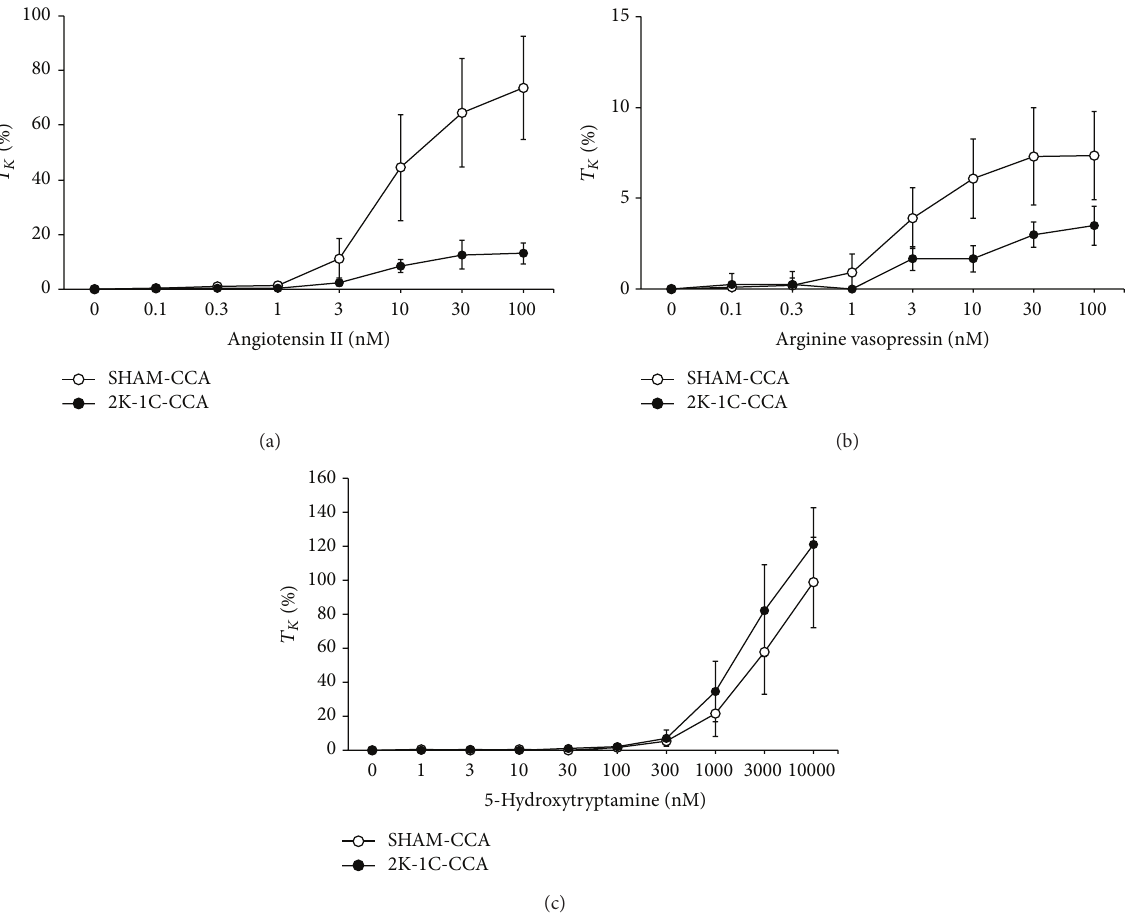
Figure 4: Dose-response effects of angiotensin II (a), arginine vasopressin (b), and 5-hydroxytryptamine (c) on tension of common carotid arteries from sham-operated (SHAM) and 2-kidney, 1-clip (2K-1C) hypertensive rats. The data are presented as mean ± SEM of the responses expressed as a percentage of that elicited by 80 mM K + (% 𝑇 𝐾 ). There were 6 arteries in each